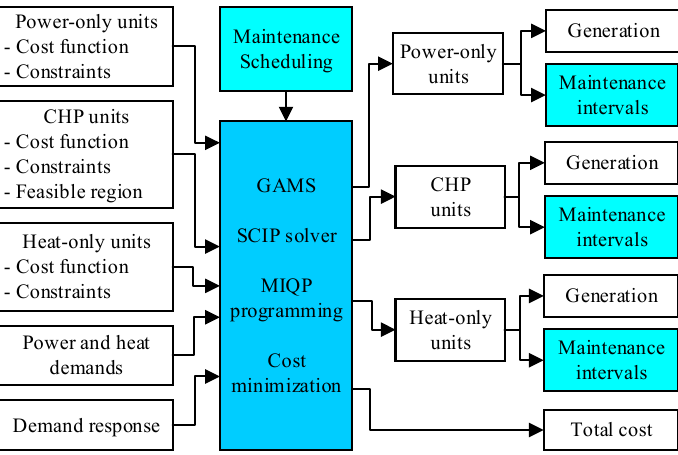
Figure 4. Flowchart of the proposed methodology.